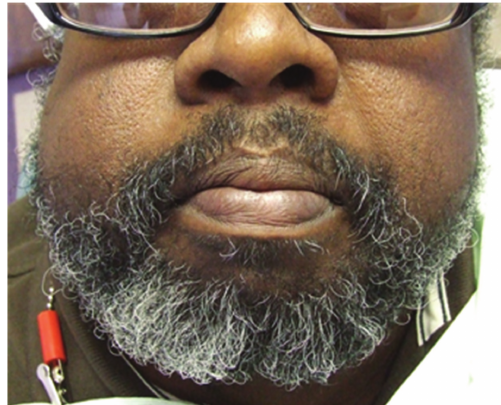
Figure 1: Extraoral presentation.